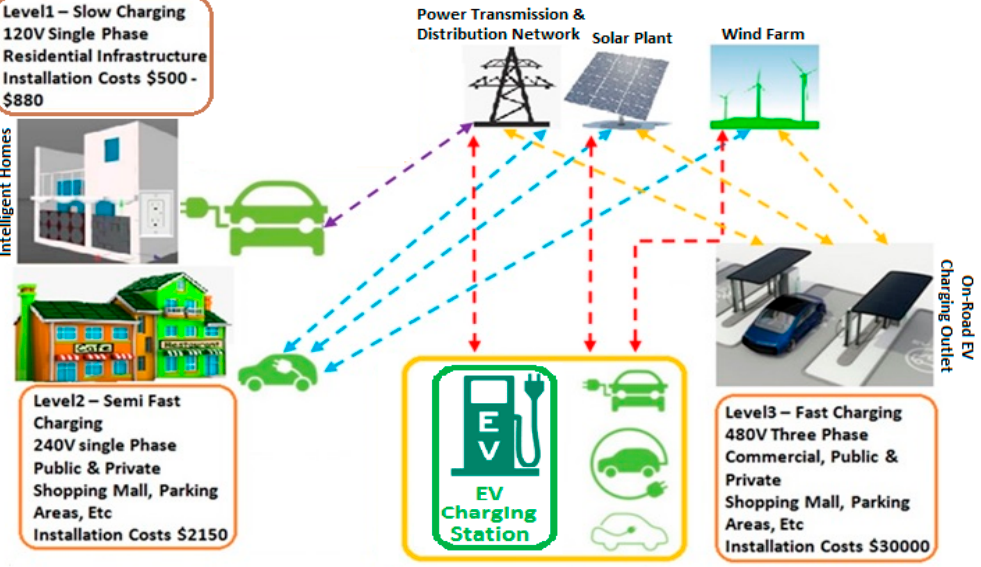
Figure 2. Levels of charging requirements.